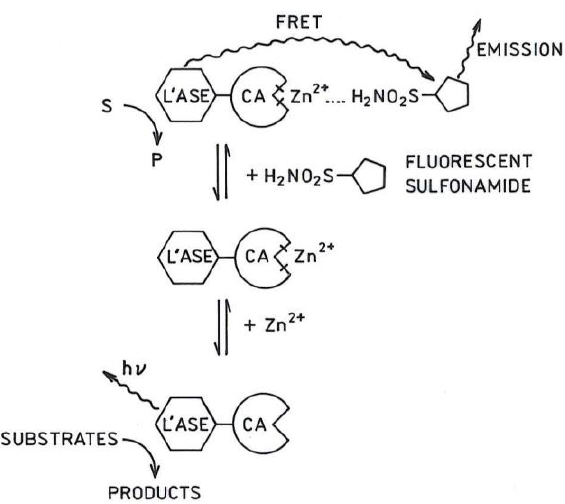
Figure 1. Principle of the sensor. In the figure, “L’ASE” indicates schematically the luciferase portion of the fusion protein, “CA” the carbonic anhydrase portion of the fusion protein, and “FRET”, Förster resonance energy transfer.